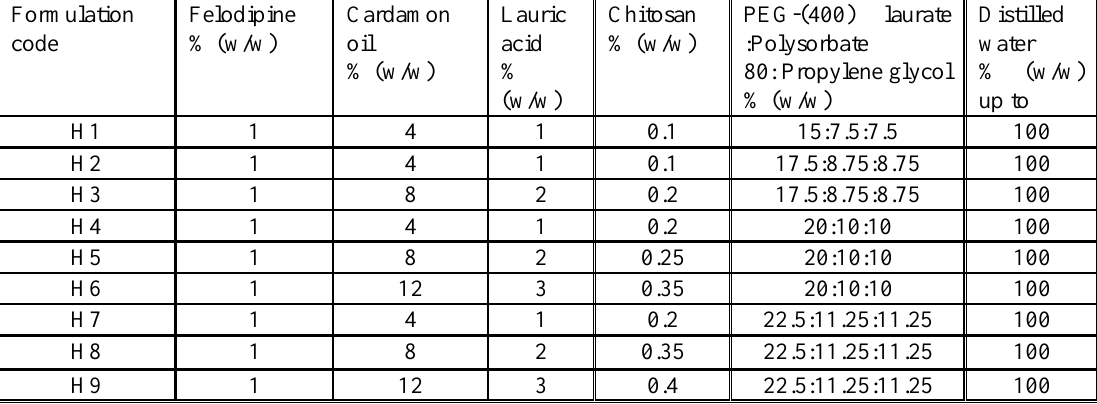
Table 1. The quantitative components of felodipine LPHNs formulations (H1-H9) for characterization and optimization Formulation